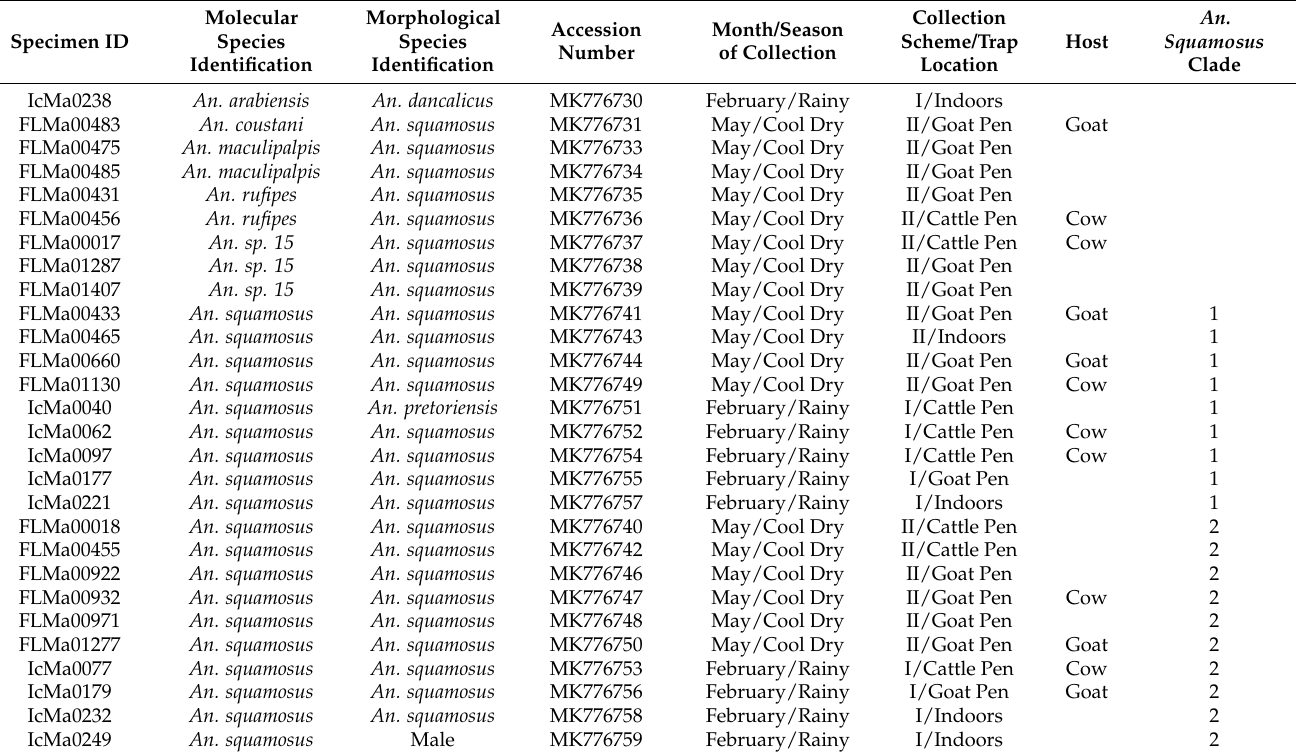
Table 4. GenBank accession numbers, morphological and molecular species identifications, month/season and location of collection, and host choice for all specimens included in the phylogenetic analysis in this study. Anopheles squamosus clades are also listed for all molecularly confirmed An. squamosus specimens. All samples were collected in